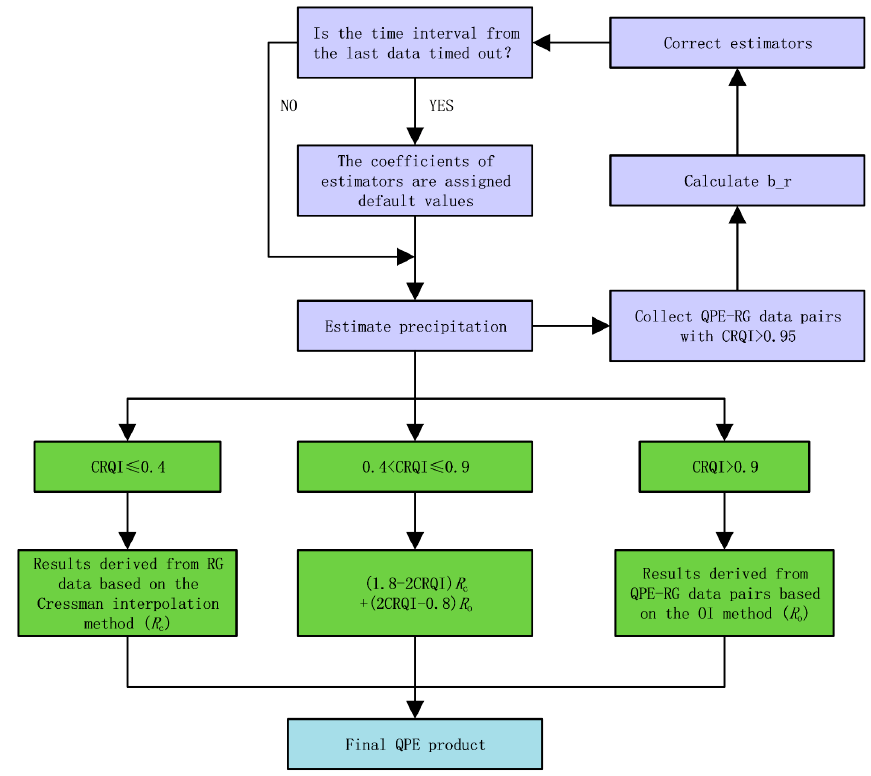
Figure 3. Flowchart of the algorithm combining PR and RG data for QPE. The purple blocks represent the process of using RG data to correct estimators in real-time. To avoid instability in the rainfall rate, the hourly accumulated precipitation is evaluated. The rainfall estimators are corrected hourly to improve the QPE accuracy. The bias ratio between QPE and the RG observation (b_r) is calculated first: